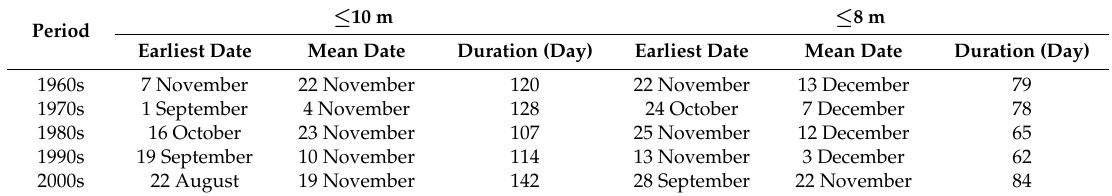
Table 2. Date statistics of the water level below 10 m and 8 m at Xingzi during different periods.